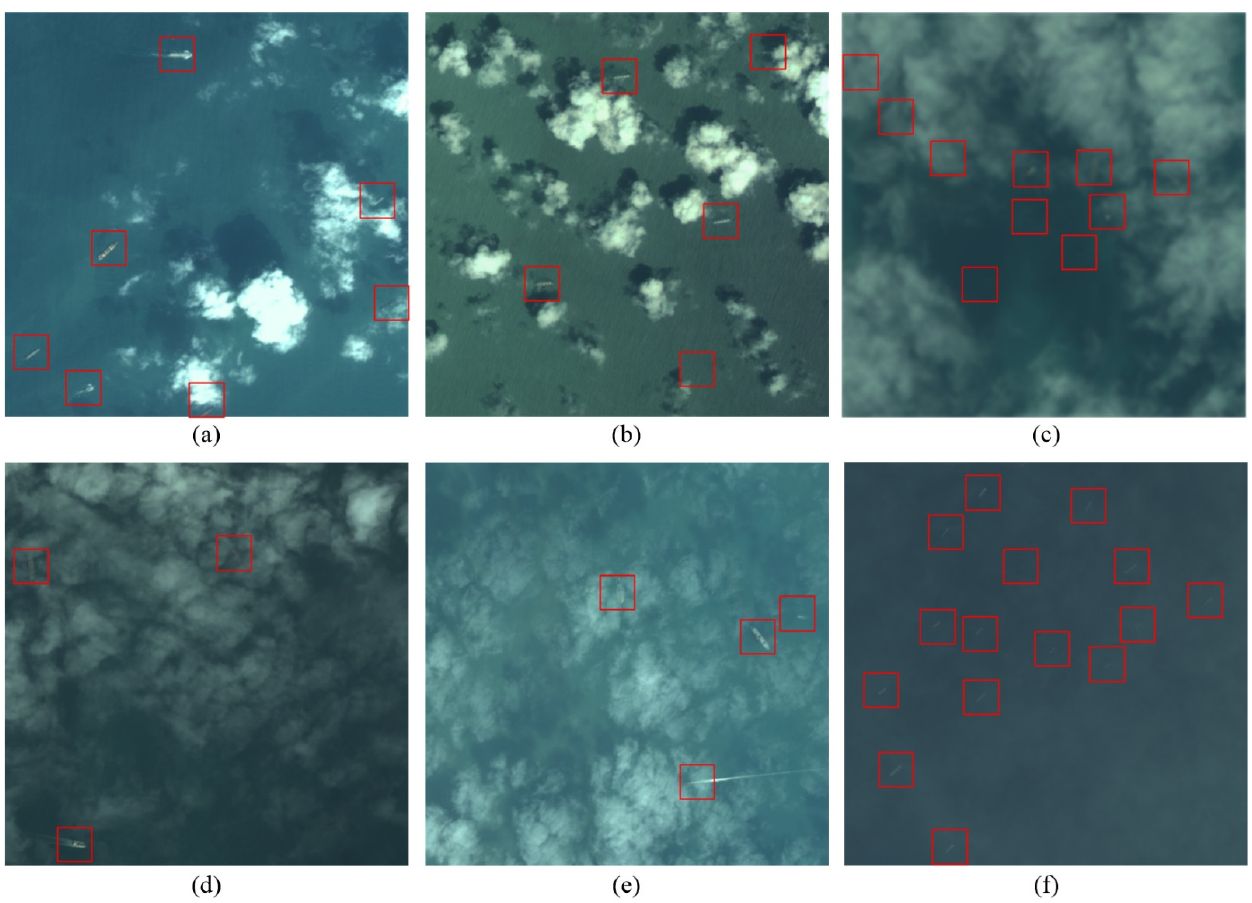
Figure 9. Final detection results of the images in Figure 3. The red square is the mark of the detected target. We can see that the objects in the graph are detected with our method. ( a – f ) are the final target detection results marked in red squares using the images of Figure 3a–f.